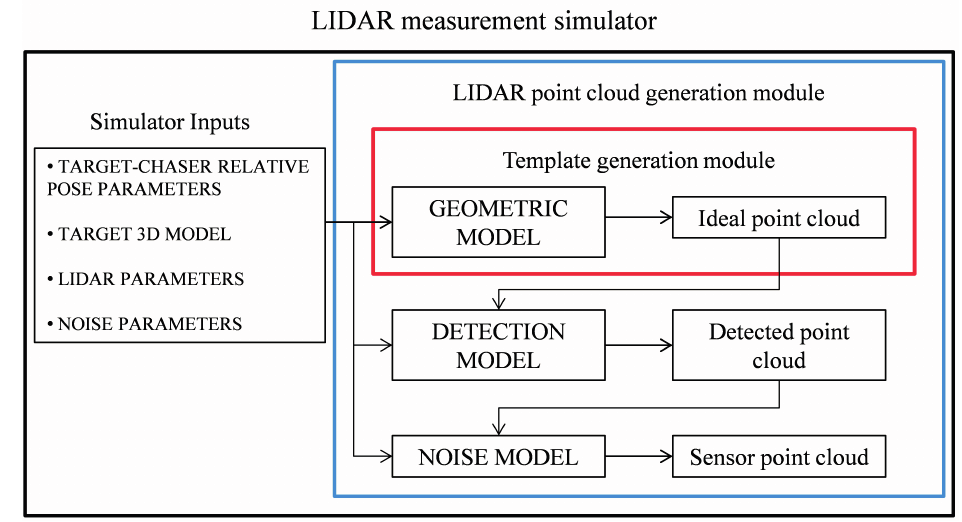
Figure 4. LIDAR measurement simulator: LIDAR point cloud and template generation